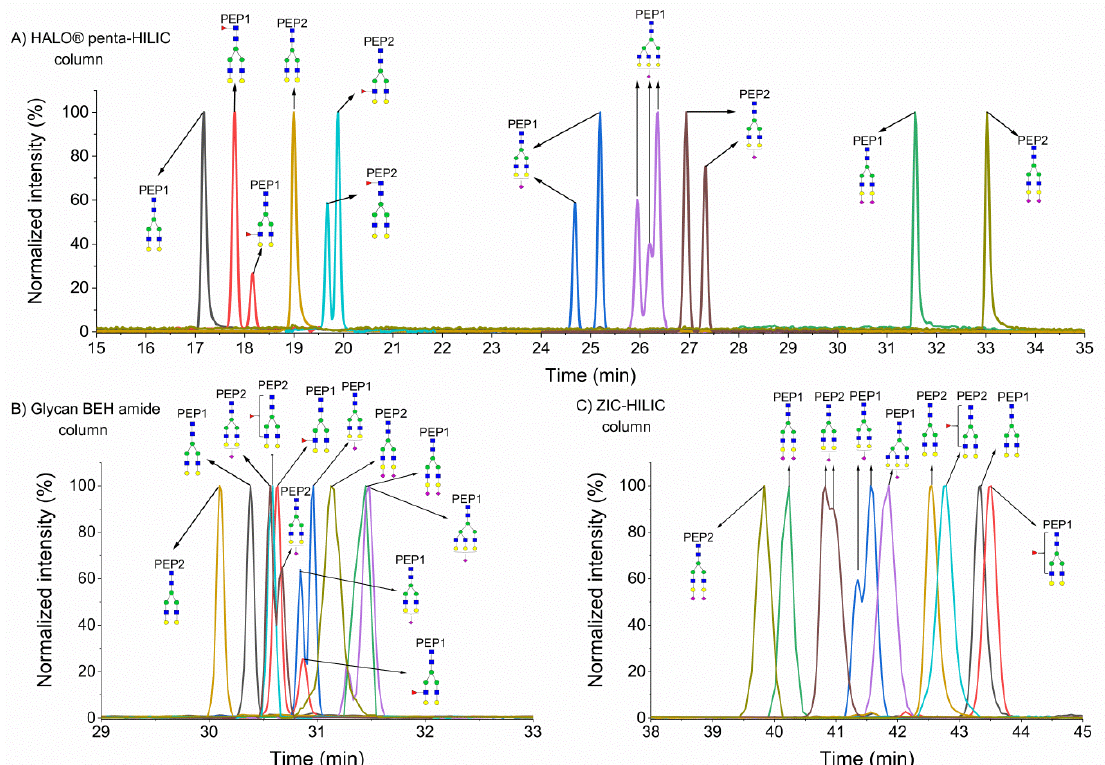
Figure 1. Separation of glycopeptides of hemopexin in HALO ® penta- hydrophilic interaction liquid chromatography (HILIC) ( A ), Glycan ethylene bridged hybrid (BEH) amide ( B ), and ZIC-HILIC ( C ) columns. PEP1 refers to SWPAVGN 187 CSSALR, and PEP2 to ALPQPQN 453 VTSLLGCTH.